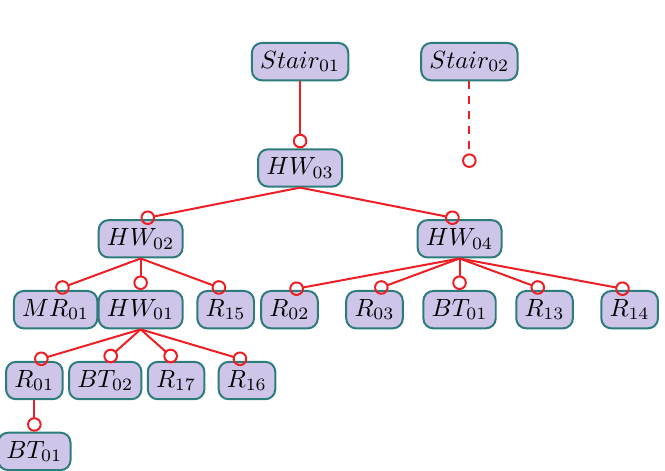
Figure 13: Part of a location hierarchy derived from a fi ne-grained graph of Figure